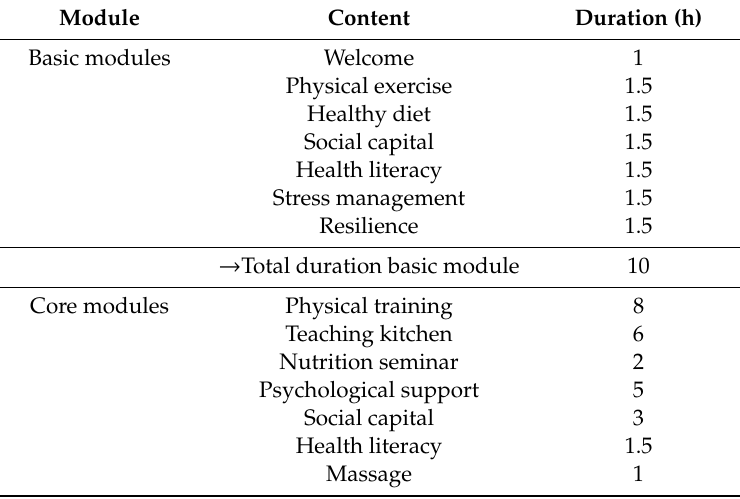
Table 3. Details for all